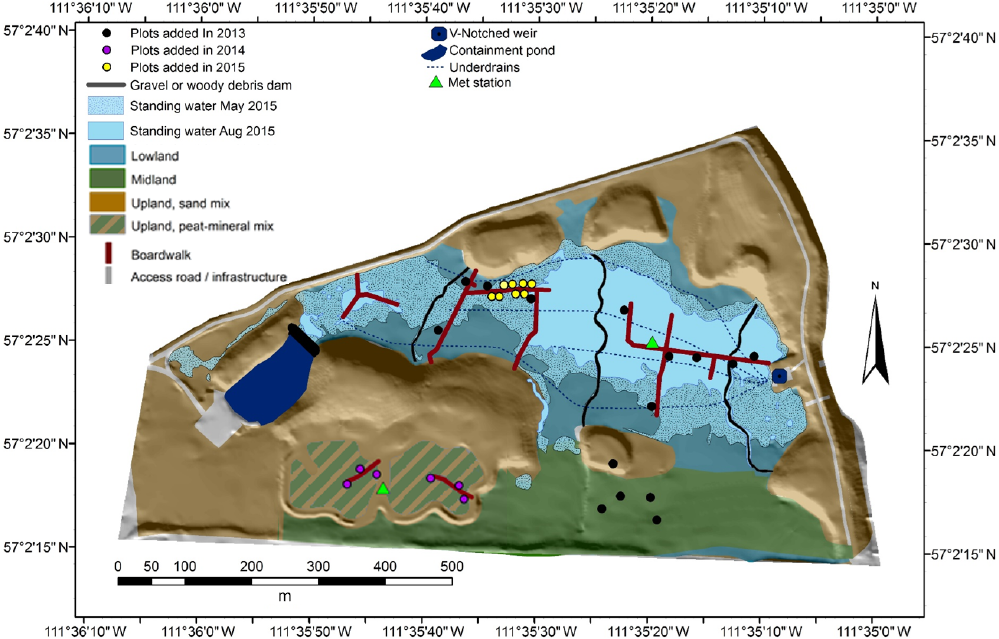
Figure 1. Map of the Sandhill Fen Watershed. Standing water was limited to the lowland region